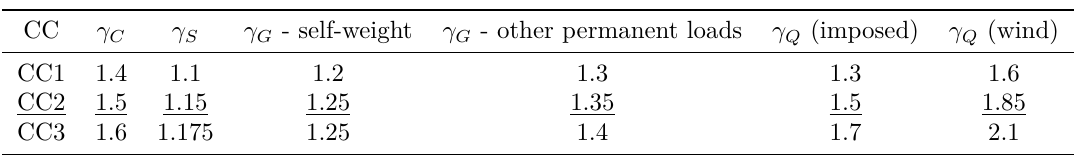
Table 2. Recommended values of partial factors for design according to MC 2020 and various CCs.